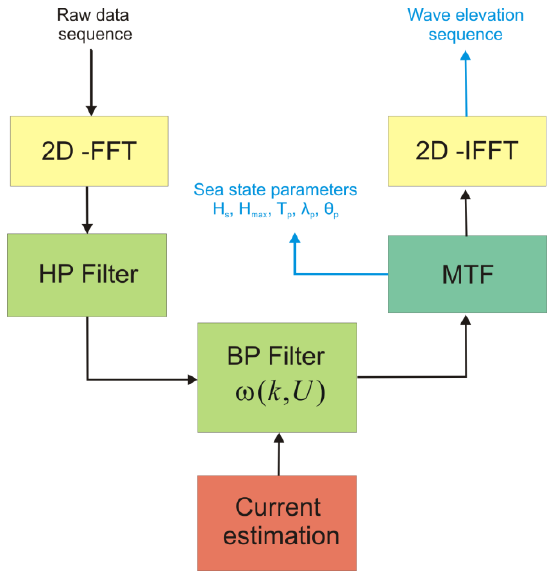
Figure 1. Block diagram of the inversion